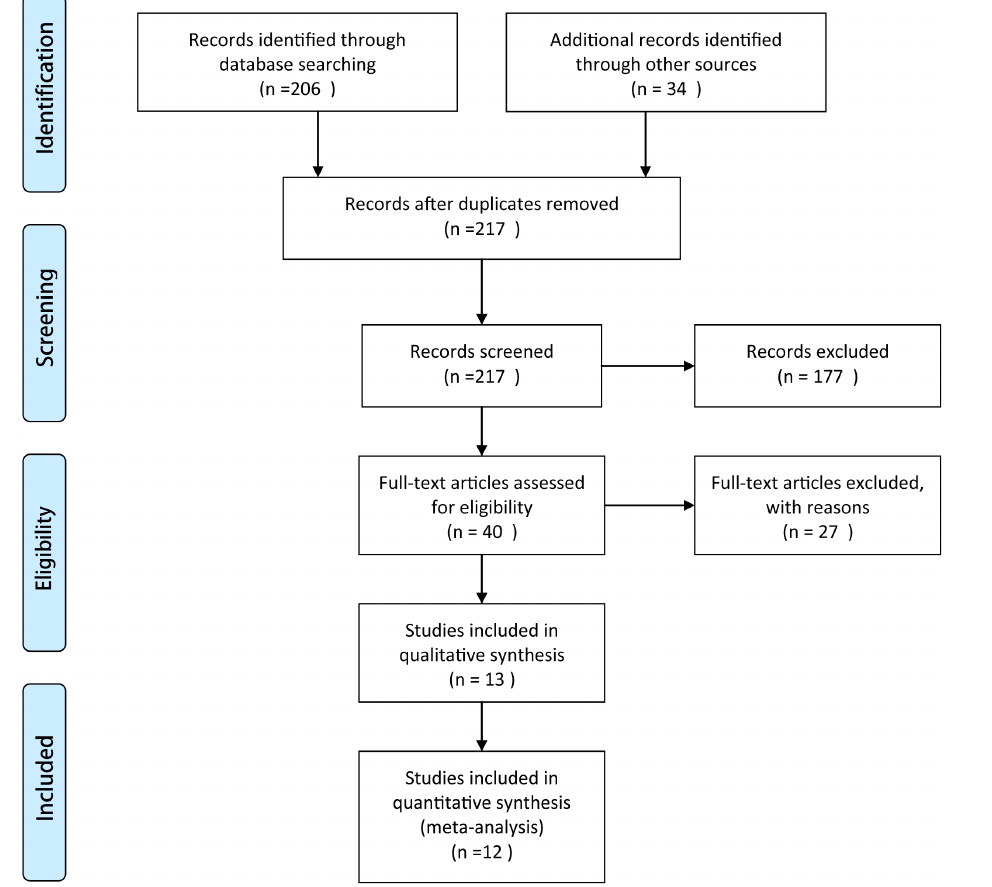
Figure 1. Flow chart of the studies recruited in this meta-analysis.